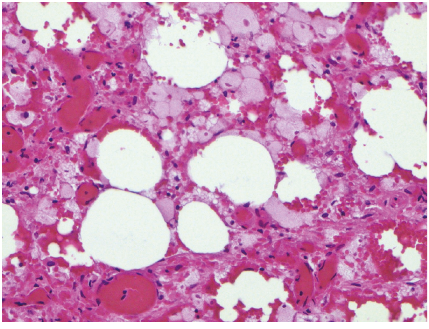
Figure 11: Omentum – fat